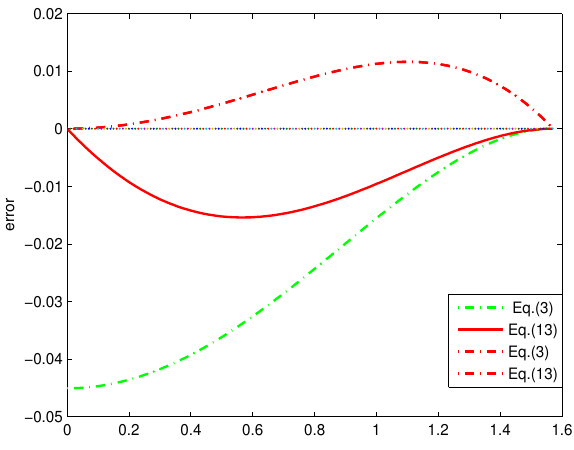
Figure 2. Error plots between sinc(x) and the bounds of Equations (3) and